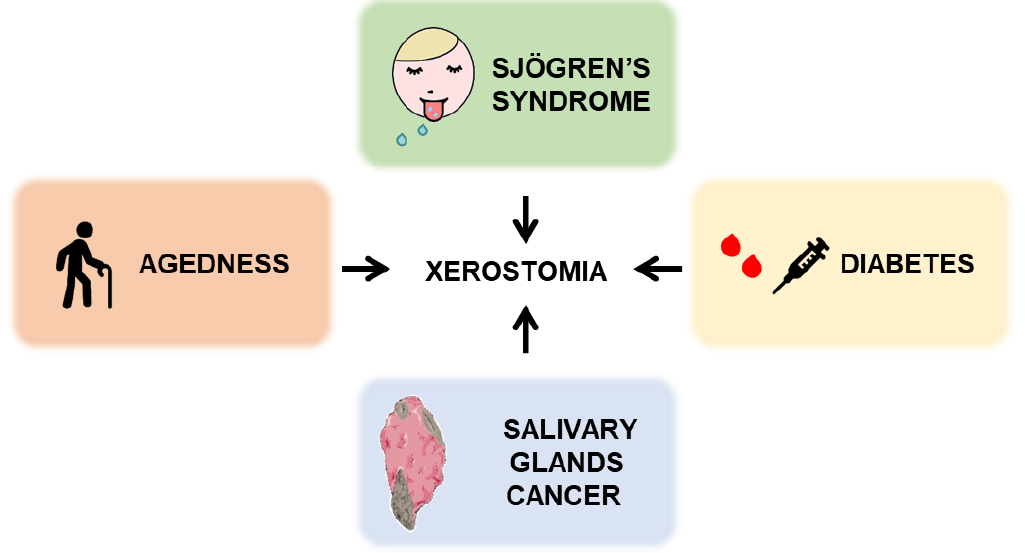
Figure 3. Pathologies leading to xerostomia. Sjögren’s syndrome, diabetes, SG cancer and senescence are often associated with a significant reduction in saliva flow that could partly result from AQP5